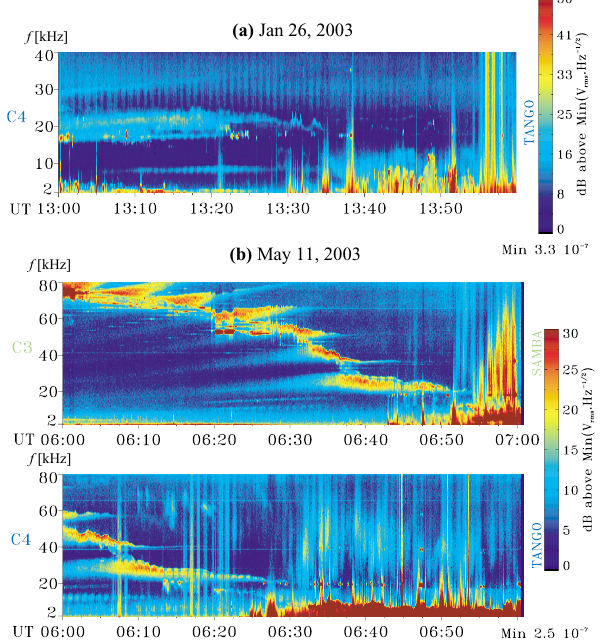
Fig. 3. WHISPER sounder electric field spectrograms for the two dates studied. The spectrograms show the intensity of the electric field. These three different days show a variety of electron density structures, from a very irregular plasma on the first panel to a very compressed plasmasphere on the second and third panels, where the plasma is smoother. Panel (a) corresponds to data recorded on 26 January 2003. Panel (b) corresponds to data recorded on 11 May 2003.